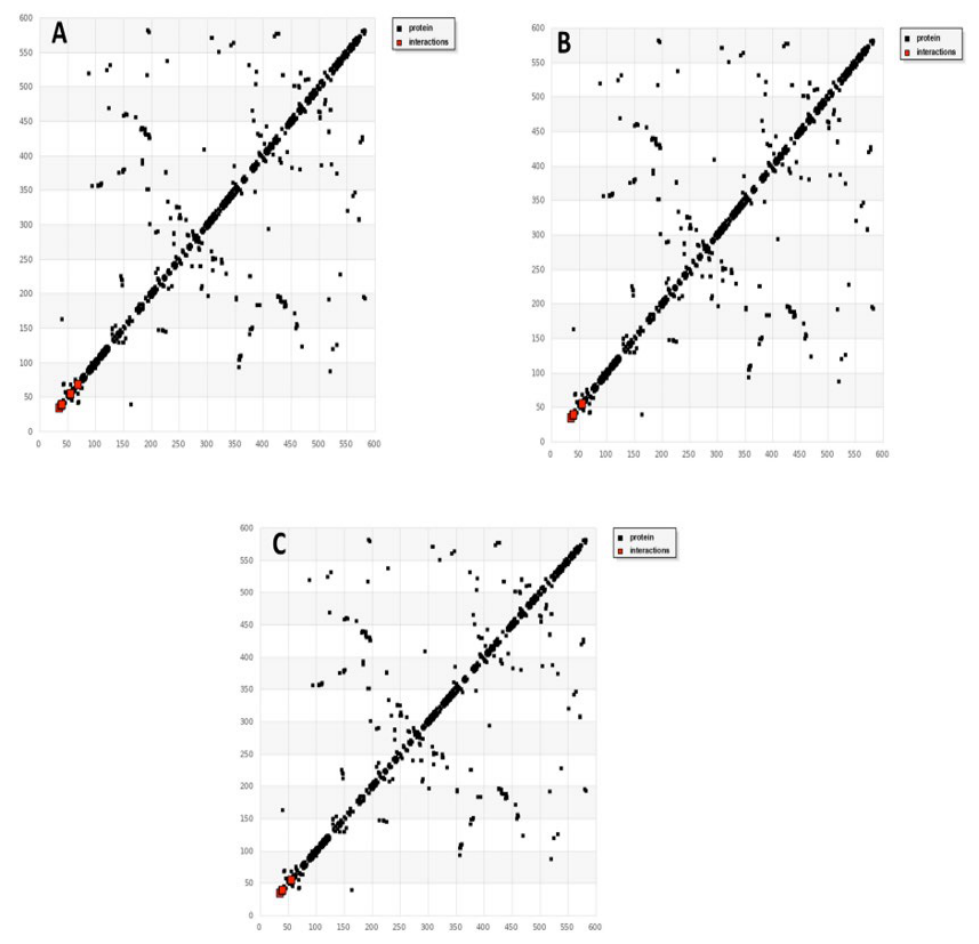
Figure 4. ( A – C ) HB plot representations docking against COX-1 enzyme. For esters 3d , g , and a respectively.